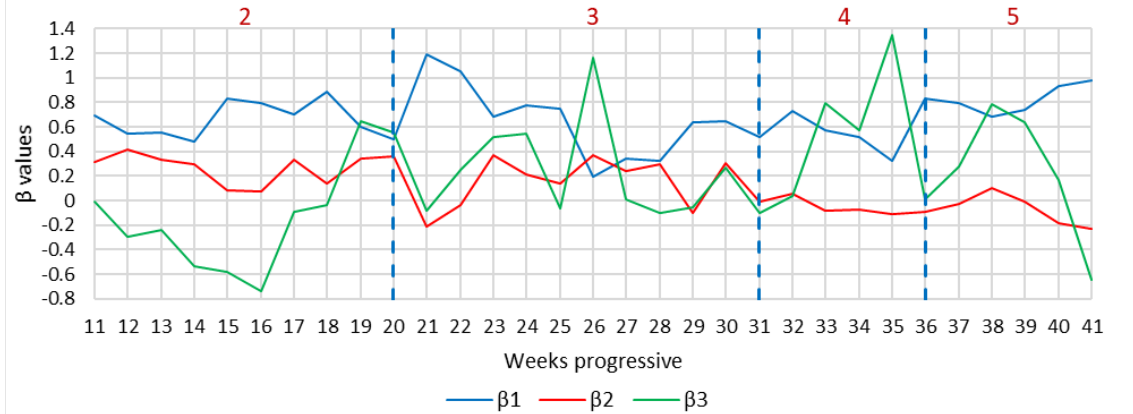
Figure 9. Scaled (standardized) beta-coefficients graphs (Equation